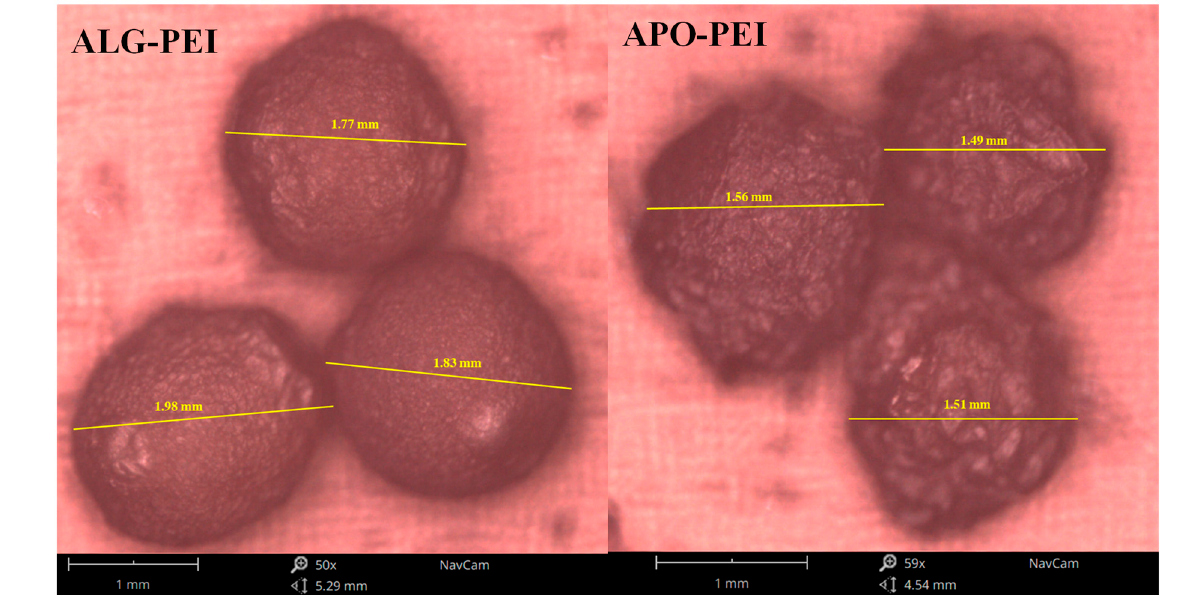
Figure A1. SEM photos for shape and size evaluation of sorbent particles.